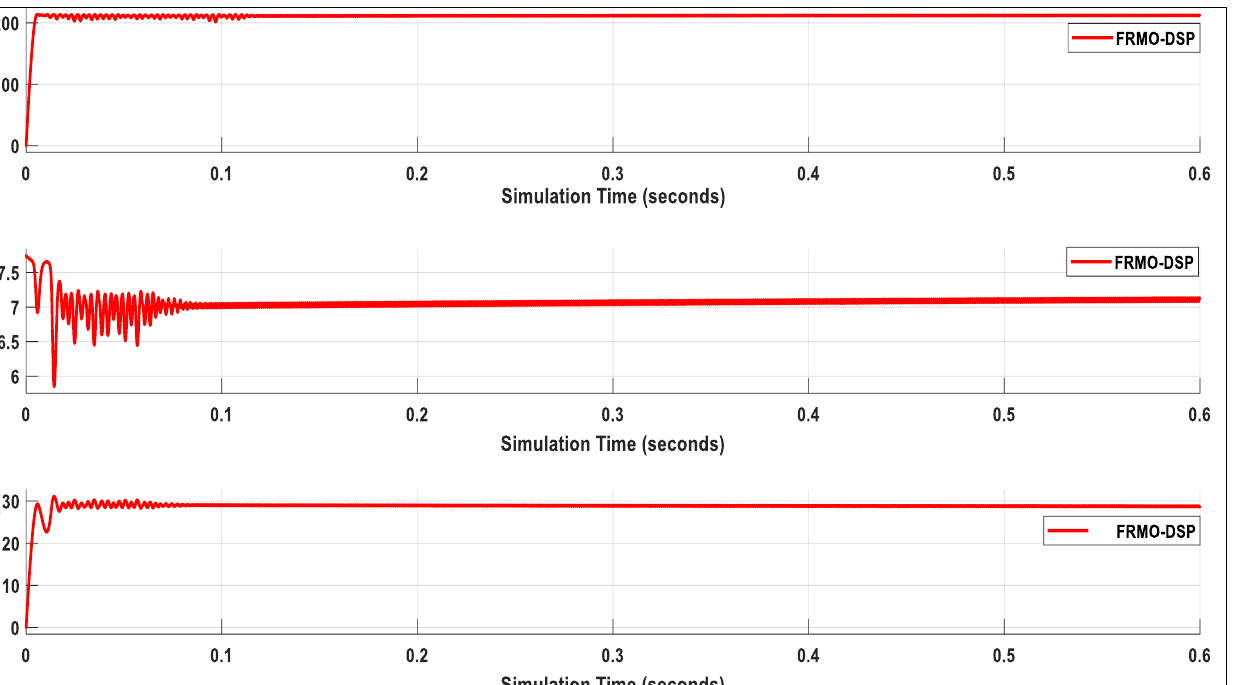
Figure 16. Case study 2 Three-phase grid voltages and current with ICLS-DSOGI-PLL.